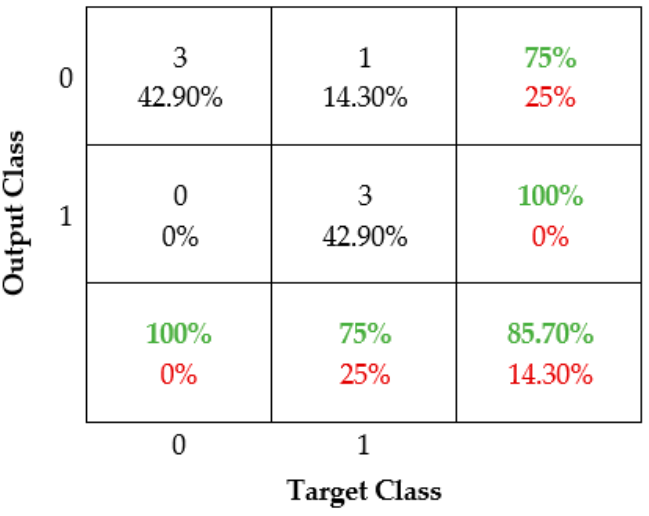
Figure 5. Confusion matrix of SVM classifier.